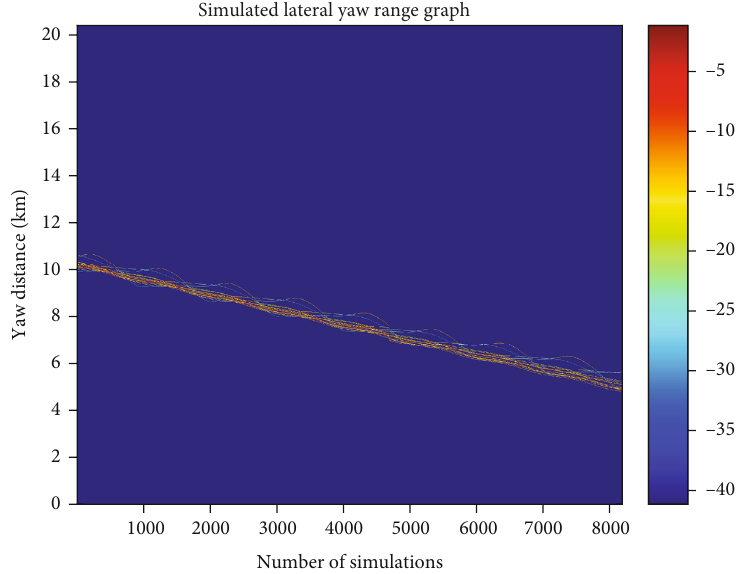
Figure 8: The simulated yaw curve under the ADS-B pulse pair.